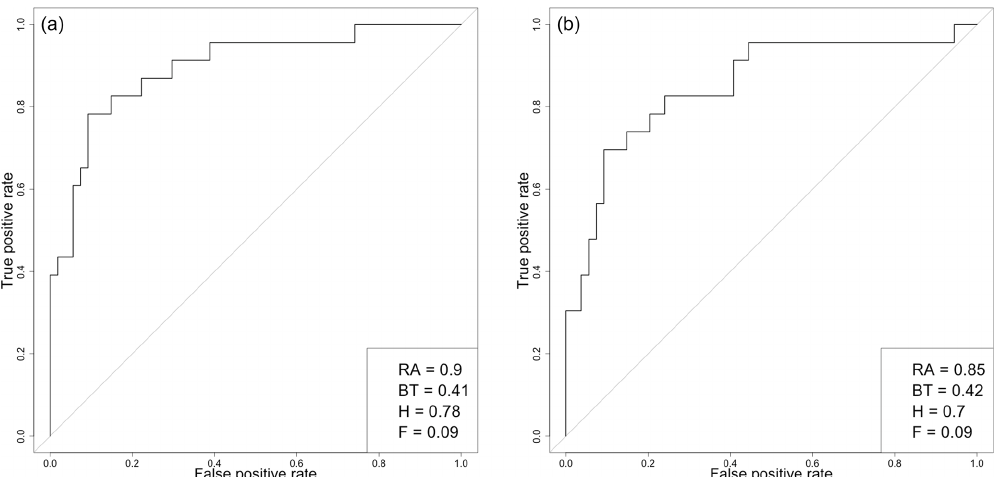
Figure B2. Relative operating characteristic (ROC) diagrams ( a : in-sample validation; b : out-of-sample validation) for above 70th percentile of damage predictions using Eq. (5) for the Valencian Community ( P 0 = 40mmd − 1 ). Each value of the ROC curves indicates a set of probability forecasts by stepping a decision threshold with 1% probability through the modelling results. The numbers inside the plots are the ROC area (RA) and the best threshold (BT), here defined as the threshold that maximizes the difference between the hit rate ( H ) and the false-alarm rate ( F